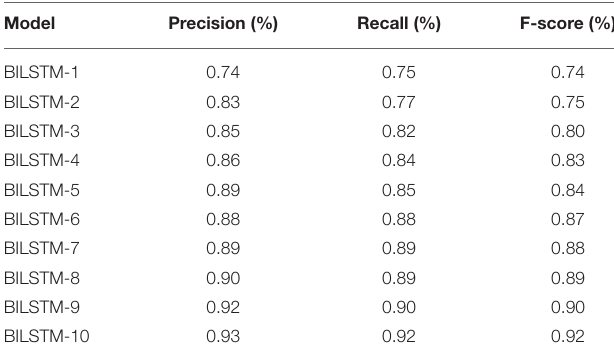
TABLE 2 | BILSTM deep learning models’ accuracy, recall, and f1-score.